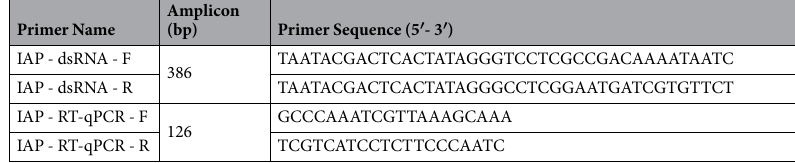
Table 4. Primers used in RT-qPCR and dsRNA